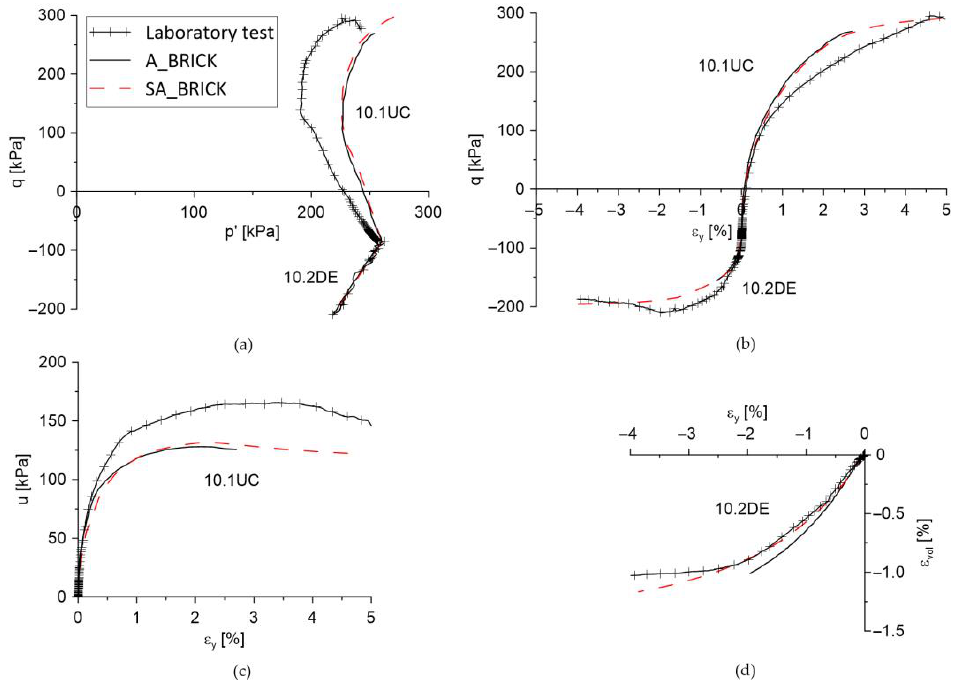
Figure 7. Validation of the SA_BRICK model against the A_BRICK model [44] on laboratory samples 10.1UC and 10.2DE: ( a ) q – p´ diagram; ( b ) q –ε y diagram; ( c ) u –ε y diagram; ( d ) ε y –ε vol diagram (only 10.1UC and 10.2DE: ( a ) q–p (cid:48) diagram; ( b ) q– ε y diagram; ( c ) u– ε y diagram; ( d ) ε y – ε vol diagram (only for for sample 10.2DE). sample